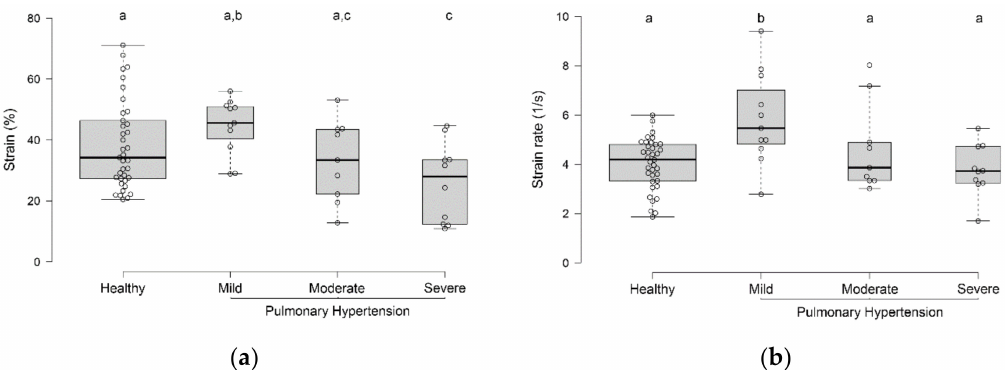
Figure 2. Box-and-whisker plots of transverse strain ( a ) and strain rate ( b ) values in healthy dogs and dogs with various severities of pulmonary hypertension. Groups with di ff erent superscripts (a, b, c) di ff ered from each